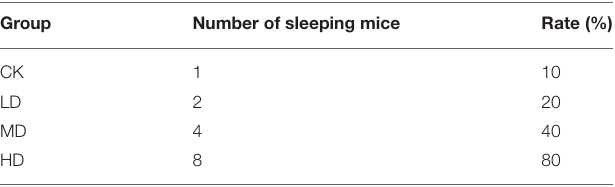
disappearance of the righting reflex was recorded and compared with the control